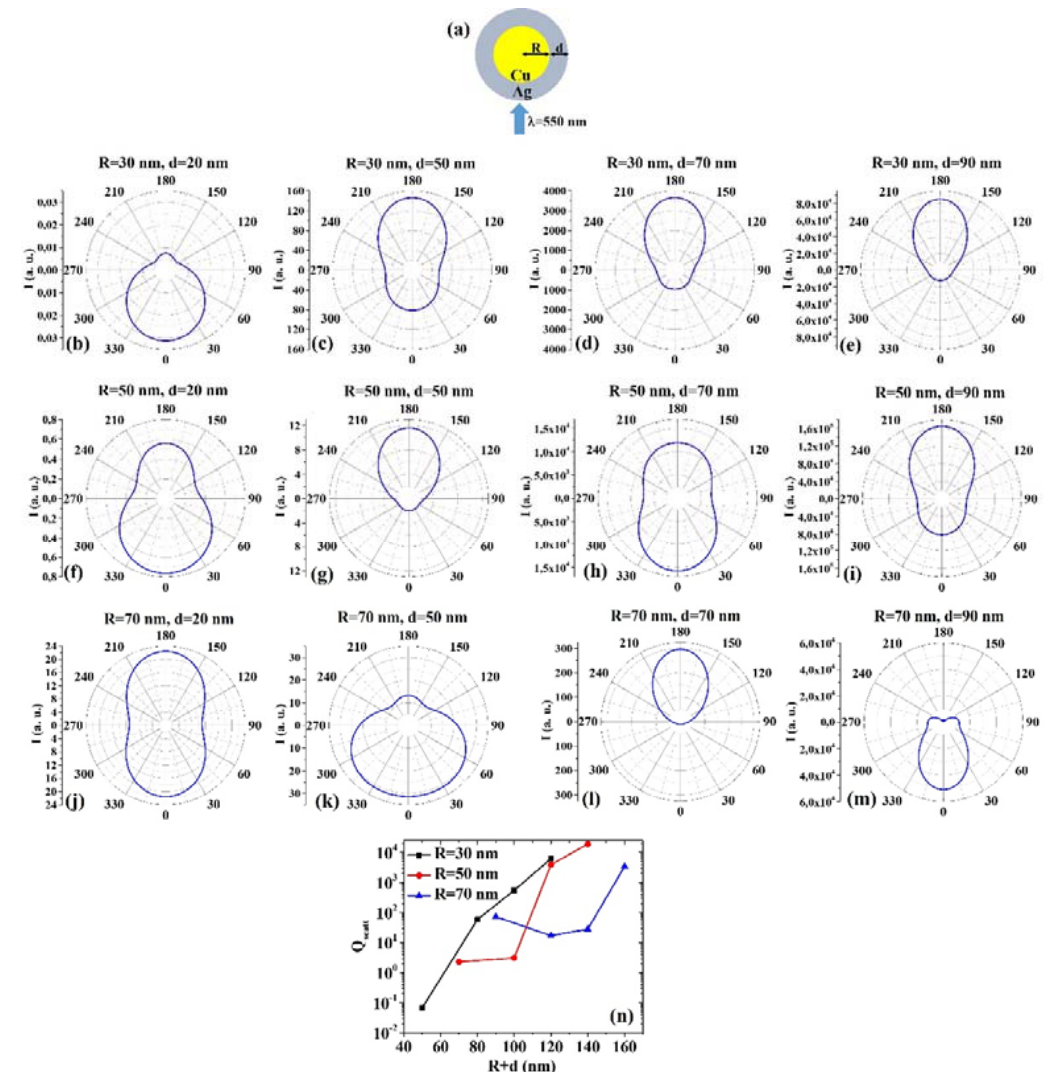
Figure 3. ( a ) Scheme of the structure of the simulated Cu/Ag core/shell spherical particle with core radius R and shell width d and electromagnetic radiation of wavelength λ = 550 nm impinging on the particle from 0°. ( b – m ) Calculated polar diagrams for the intensity of the scattered light from the Cu/Ag core/shell spherical particle changing the Cu core radius R and the Ag shell width: ( b – e ) R = 30 nm and d = 20 nm ( b ), d = 50 nm ( c ), d = 70 nm ( d ), d = 90 nm ( e ); ( f – i ) R = 50 nm and d = 20 nm ( f ), d = 50 nm ( g ), d = 70 nm ( h ), d = 90 nm ( i ); ( j – m ) R = 70 nm and d = 20 nm ( j ), d = 50 nm ( k ), d = 70 nm ( l ), d = 90 nm ( m ). ( n ) Calculated scattering efficiency for the light (wavelength λ = 550 nm) scattering process of the Cu/Ag spherical particle fixing the Cu core diameter (R = 30 nm black dots, R = 50 nm red dots, R = 70 nm blue dots) and increasing the Ag shell width d from 20 nm to 90 nm.